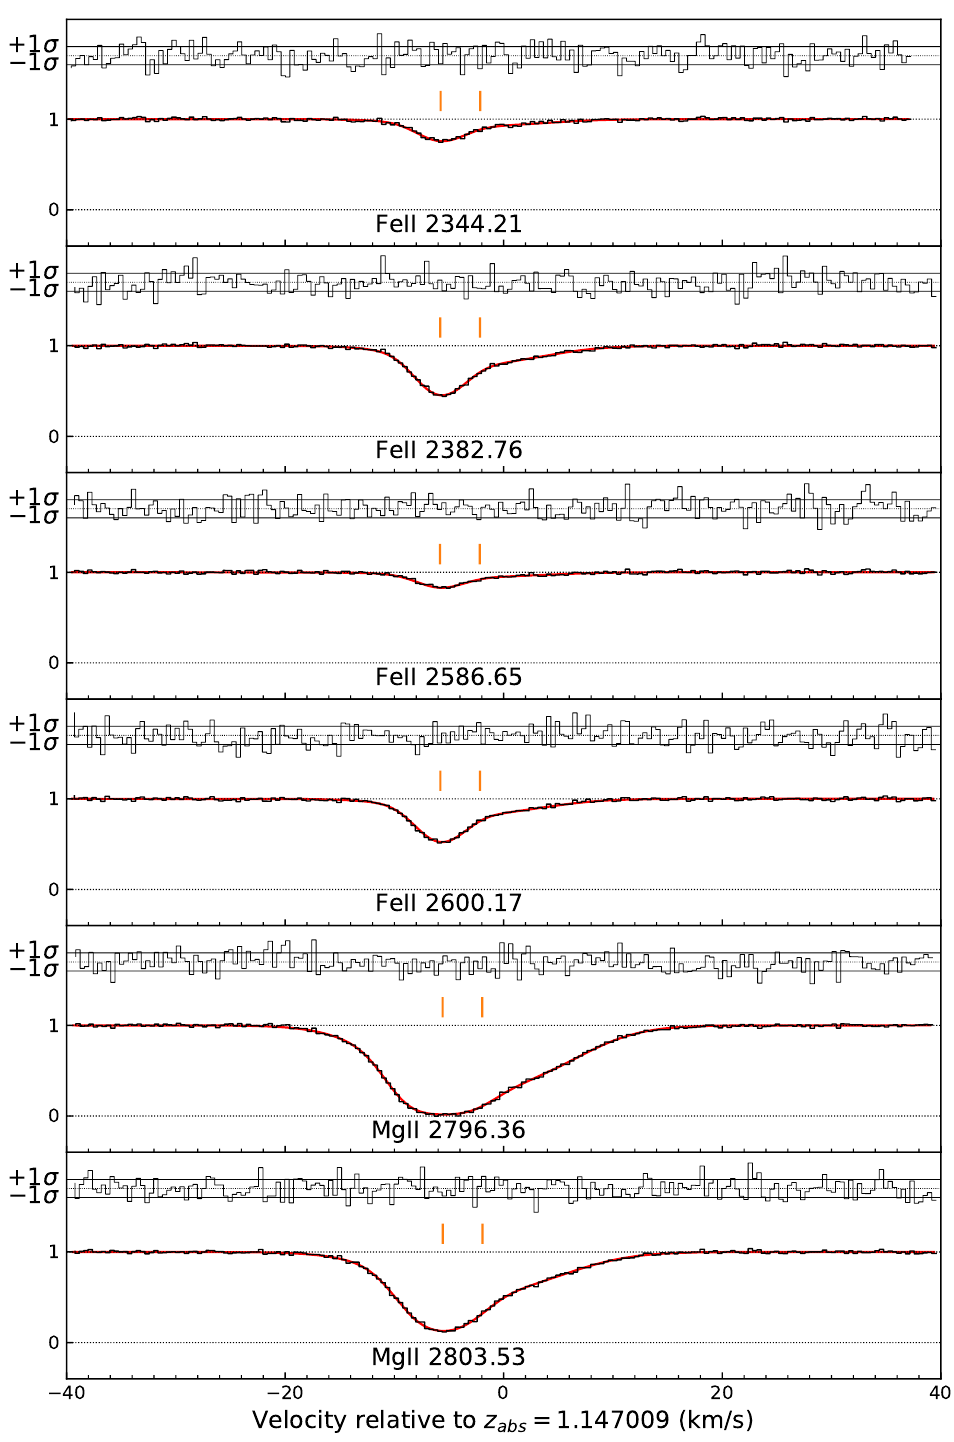
Figure 3. Synthetic spectrum fitted with 4 sets of 100 AI - VPFIT models, as described in Section 4.2. Only 6 transitions are shown (the excluded transition, Fe II 2374 Å, is very weak). The parameter details are given in Table 2. The spectral characteristics are described in Section 4.1. The model (continuous red line) is a compound broadened model, randomly selected from our set of 100 fits. Vertical tick marks illustrate the best-fit component